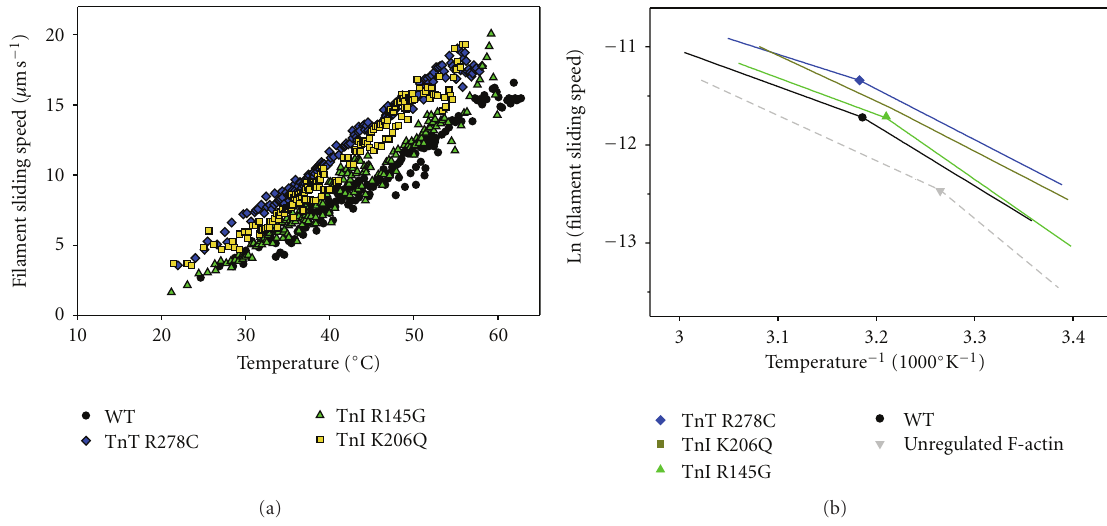
Figure 4: Influence of FHC-linked mutations in human cardiac troponin on temperature dependence of thin-filament sliding at pCa 5. Thin filaments were reconstituted with α -Tm and either rhcTn WT (circles, black), rhcTn TnI,R145G (triangles, green), rhcTn TnI,K206Q (squares, yellow), or rhcTn TnT, R278C (diamonds, blue). Data were obtained during the heating phases of multiple heating/cooling cycles, as in Figure 1; note that WT data were replotted from Figure 2(b). (a) Points represent the mean sliding speed for 3–8 filaments during 1s. Note that speeds with TnI mutant K206Q [32] and TnT mutant R278C were generally elevated over WT. (b) Arrhenius analysis of data from (a). Symbols and colors as in (a); unregulated F-actin from the same series of experiments (Figure 2(b)) was also included in (b) (inverted triangle and dashed lines; light gray). Each dataset was fit by two linear regressions after omitting data above ∼ 60 ◦ C (WT), ∼ 54 ◦ C (cTnI R145G), ∼ 51.5 ◦ C (cTnI K206Q), or ∼ 55 ◦ C (cTnT R278C). Regression lines are shown without correction for temperature-dependent changes in solvent viscosity; points correspond to T t , the intersection of each pair of lines. Filament sliding speeds are expressed in μ m s − 1